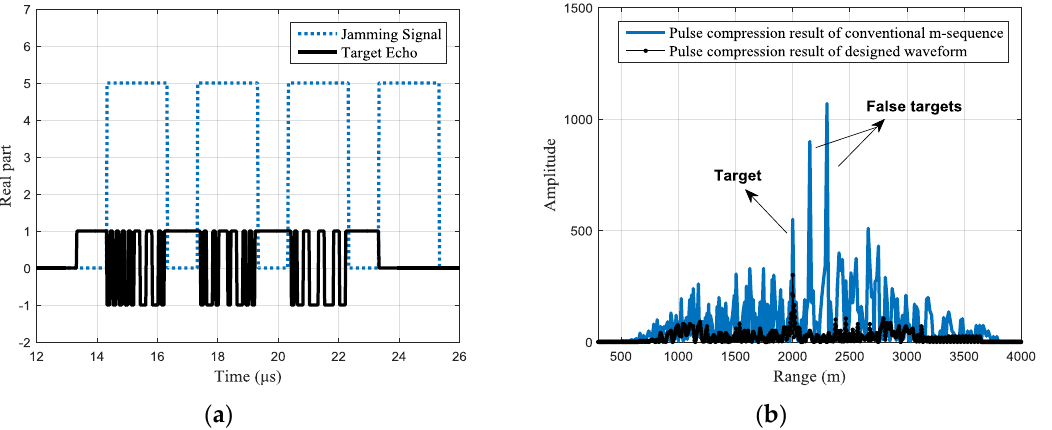
Figure 8. Jamming suppression result of a typical designed waveform (the intercepting duration is 1 μs and each jamming slice is retransmitted twice): ( a ) the real part of the received signals with a typical designed waveform ( b ) pulse compression result of the received signal.